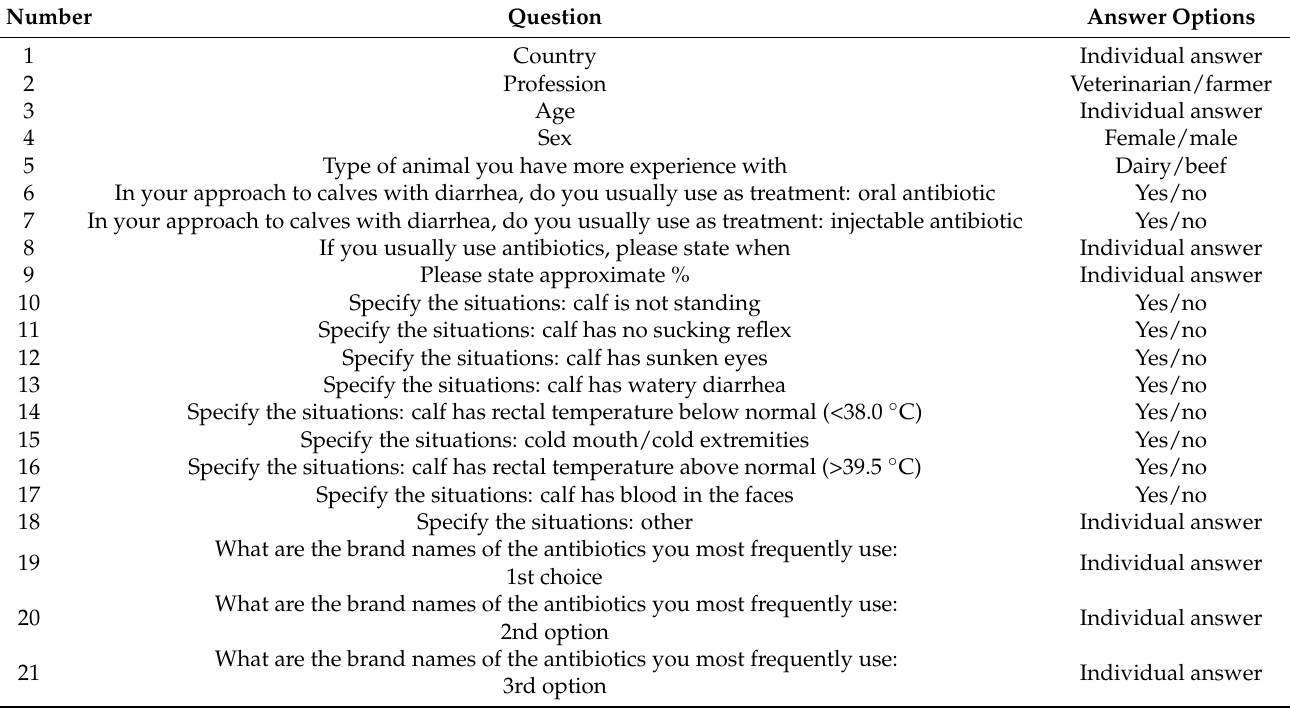
Table 3. Questions of the survey relevant for the use of antibiotics in treating